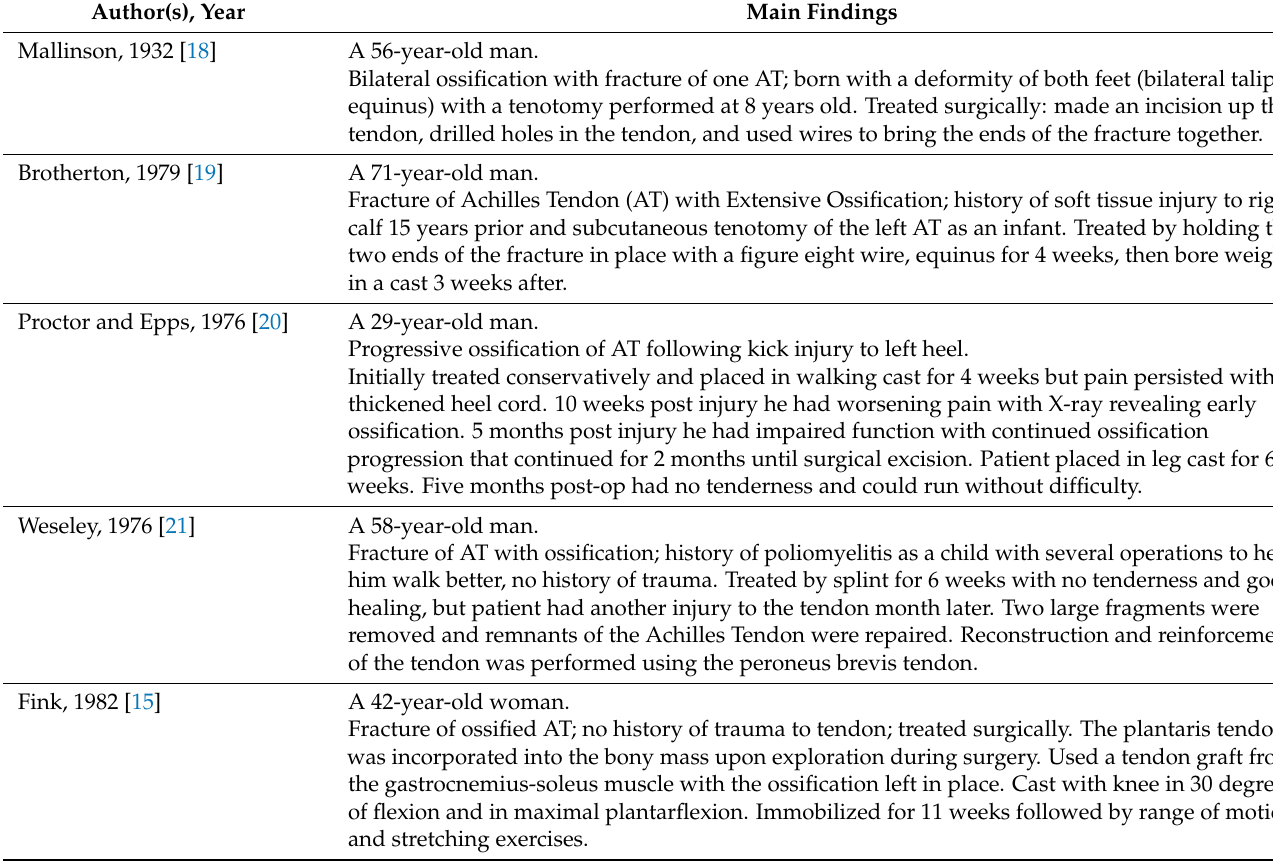
Table 1. Relevant articles (Case Reports; 1932–2020) and their main